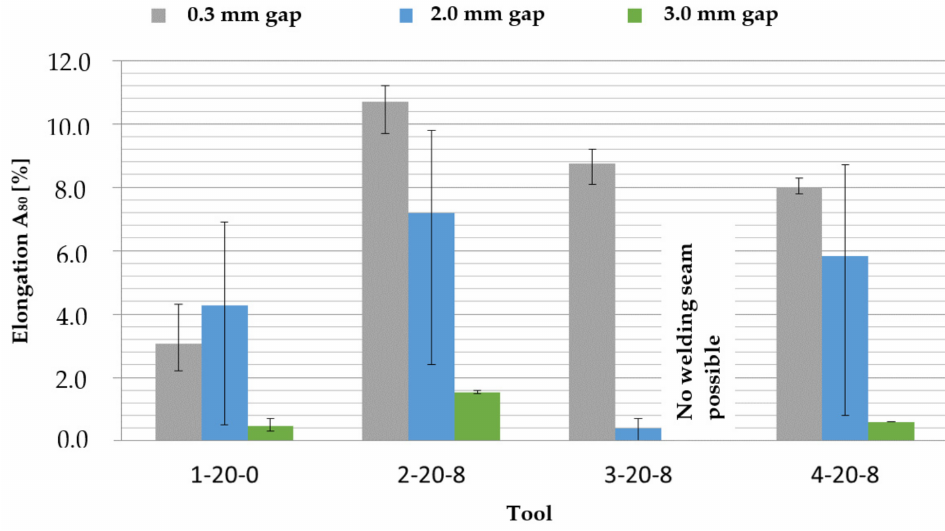
Figure 27. Elongation at break of the additional tests with joint gap widths up to 3